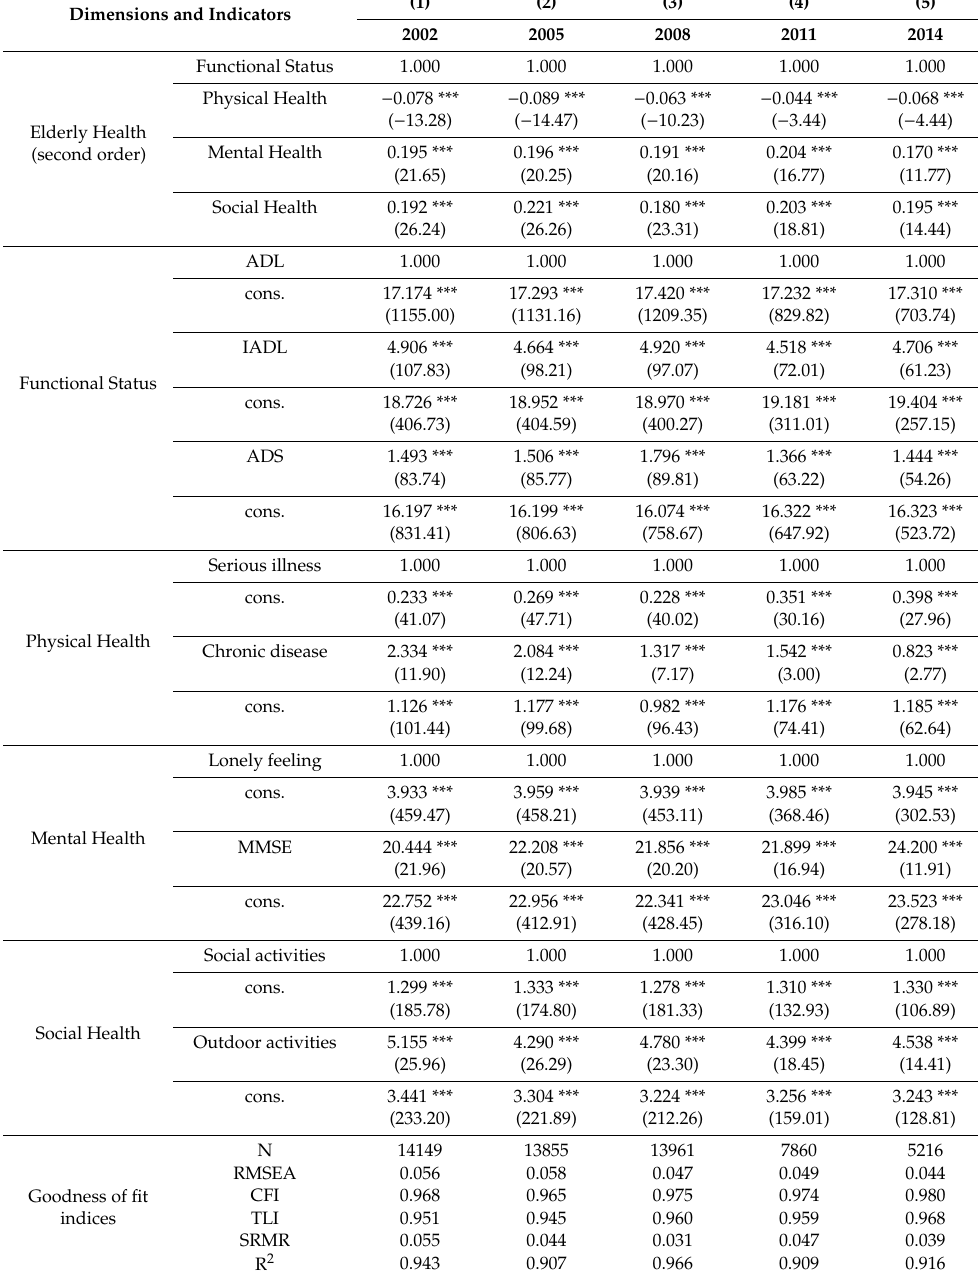
Table 3. Second-order factor model estimation